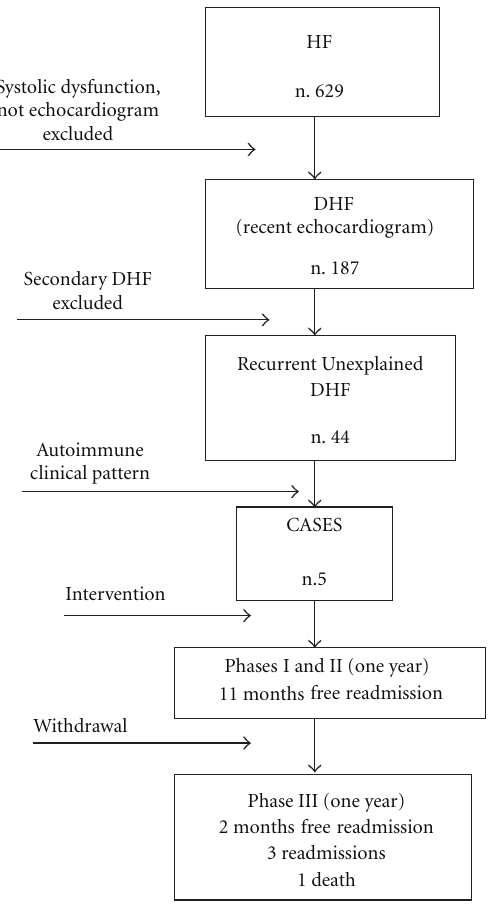
Figure 1: Protocol and phases. HF: Heart failure, DHF: Diastolic heart